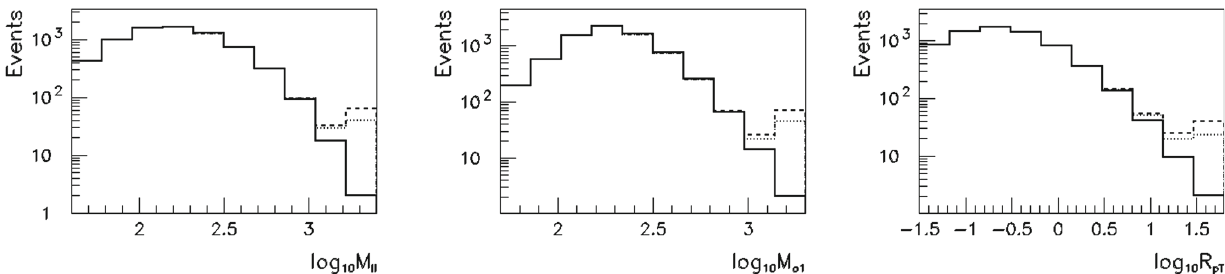
Fig. 2 Typicalexamples of kinematicdistributions used for the assess- ment of BSM signal significances. Shown are the distributions of M ll , M o 1 and R pT (in log scale): in the Standard Model (solid lines), with f T 1 = 0 . 1 / TeV − 4 and the high- M WW tail treatment according to